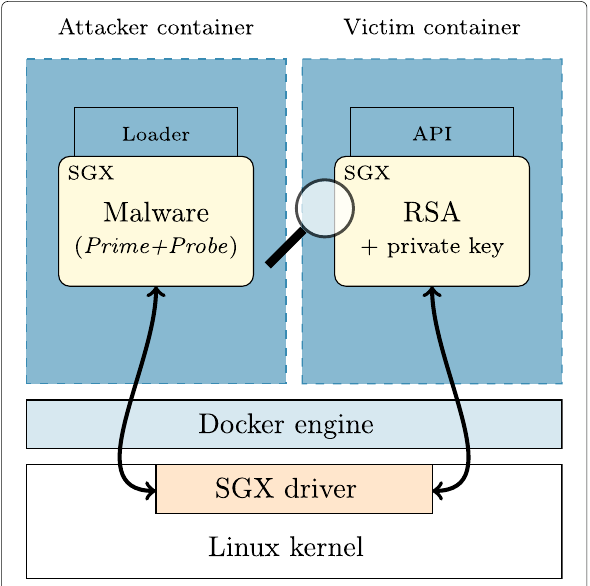
Fig. 12 Running the SGX enclaves inside Docker containers to provide further isolation. The host provides both containers access to the same SGX